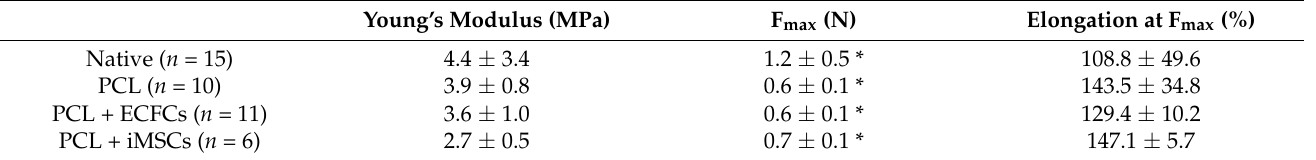
Table 1. Uniaxial tensile mechanical properties: Young’s modulus, F max , and elongation at F max of native porcine pulmonary heart valves, unseeded PCL scaffolds, and PCL scaffolds seeded with iMSCs or hECFCs for 14